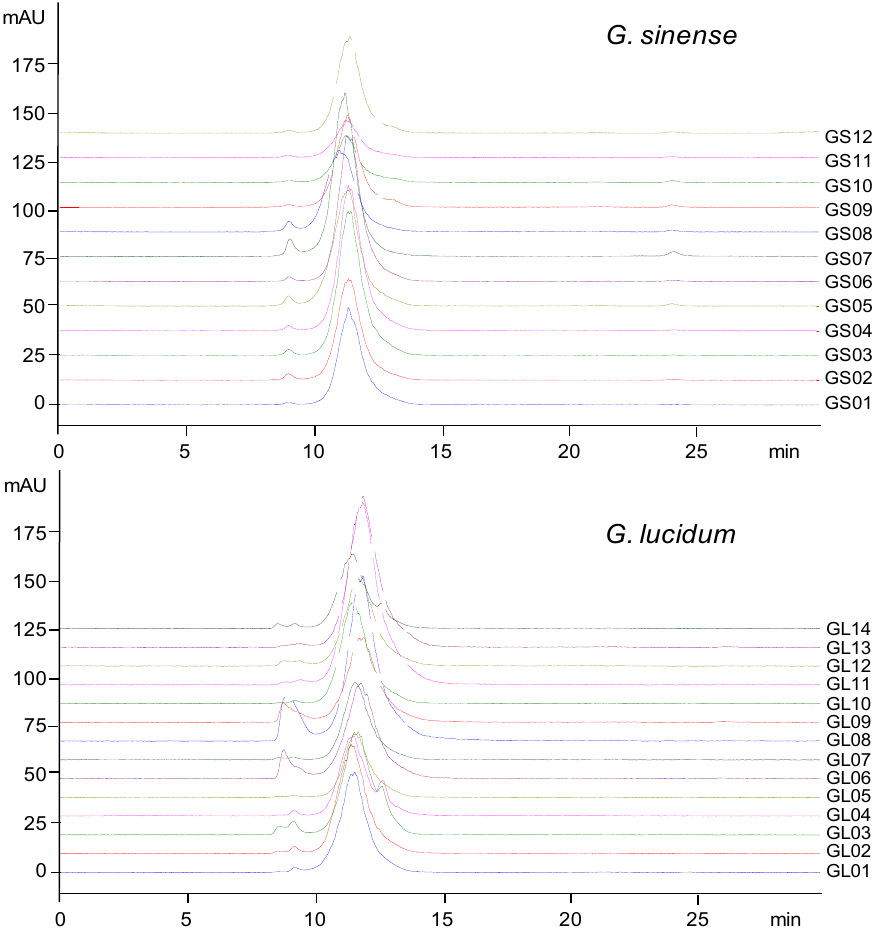
Figure 1. HPSEC-ELSD profiles of crude polysaccharides from Lingzhi .